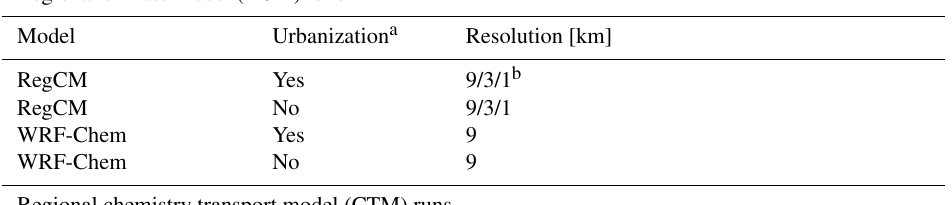
Table 1. The list of model simulations performed: the first section contains the RCM simulations that cover the whole analyzed period with the information of whether urban land surface was considered (second column). The second section lists the performed regional CTM experiments – here the second column provides information on the driving meteorological data (not needed in the case of